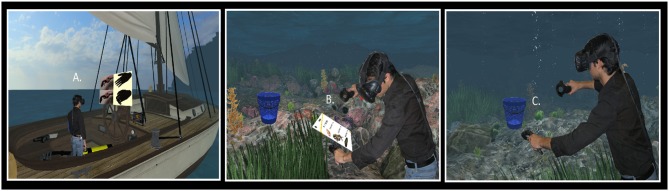
(A) The participant begins the experience by listening to an introductory narration and watching short tutorials that describe how he will interact with objects in the underwater environment. (B) The participant engages in a “species count.” He refers to the dive slate attached to his virtual left wrist to see which species are on the list, how many he has found already, and how much time is left. The participant is given 2 min to find species in the first healthy underwater zone. (C) The participant is transported to an unhealthy zone with higher levels of acidity. He is given another 2 min to conduct a species count in this area.